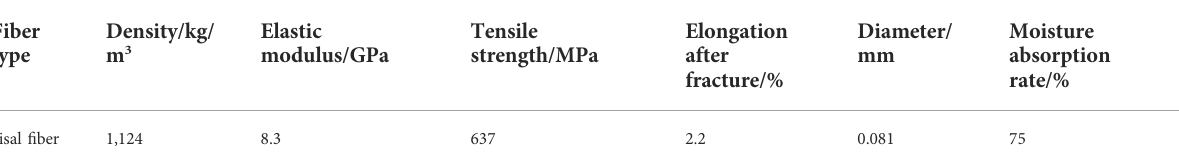
TABLE 1 Physical parameters of the fi